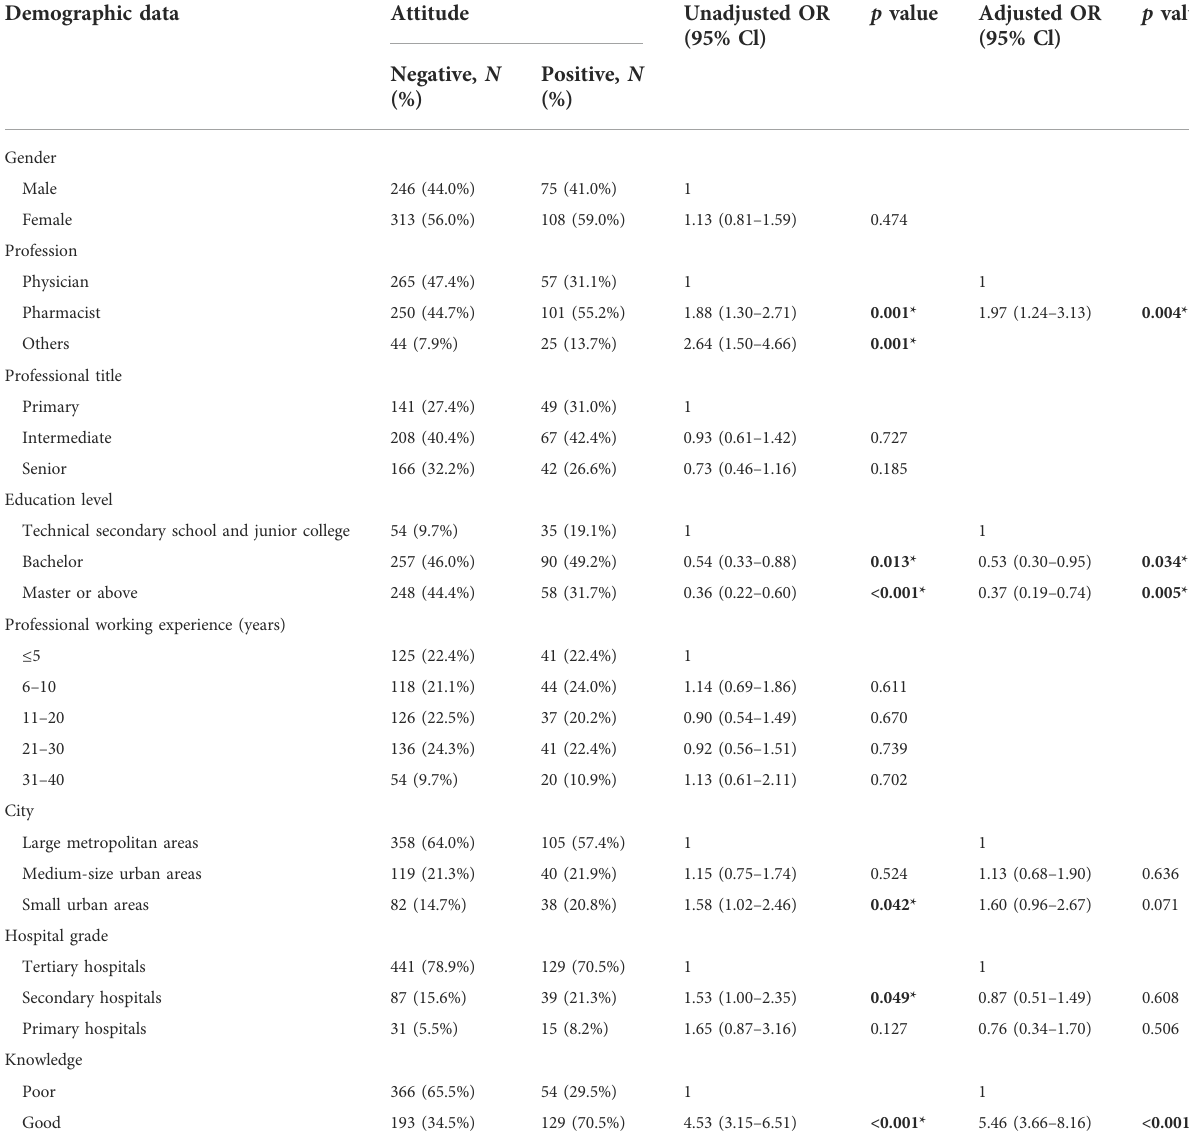
TABLE 3 Univariable and multivariable analysis of associated factors of HCPs ’ attitude towards NCDP